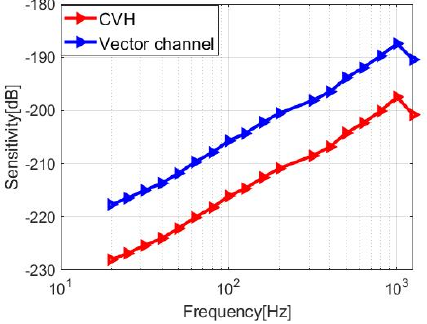
Figure 17. Sensitivity curves of CVH and vector channel (the improved cilium microstructure).